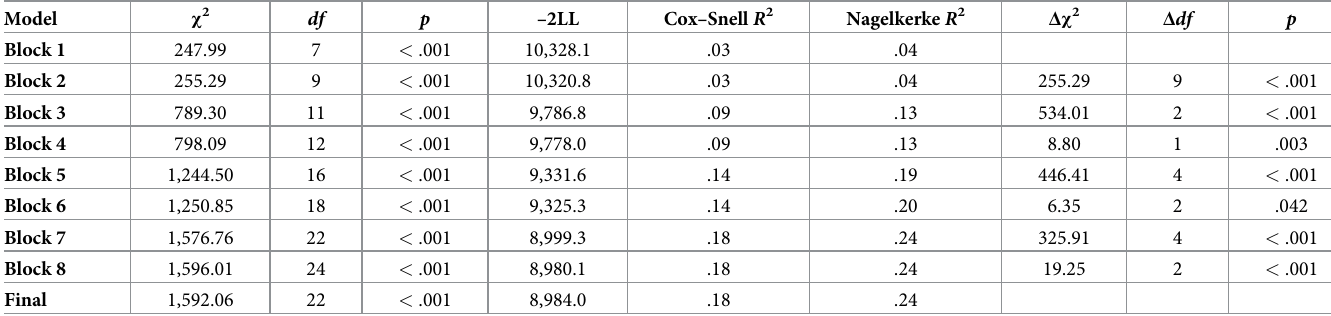
Table 4. Summary of logistic regression models built in the